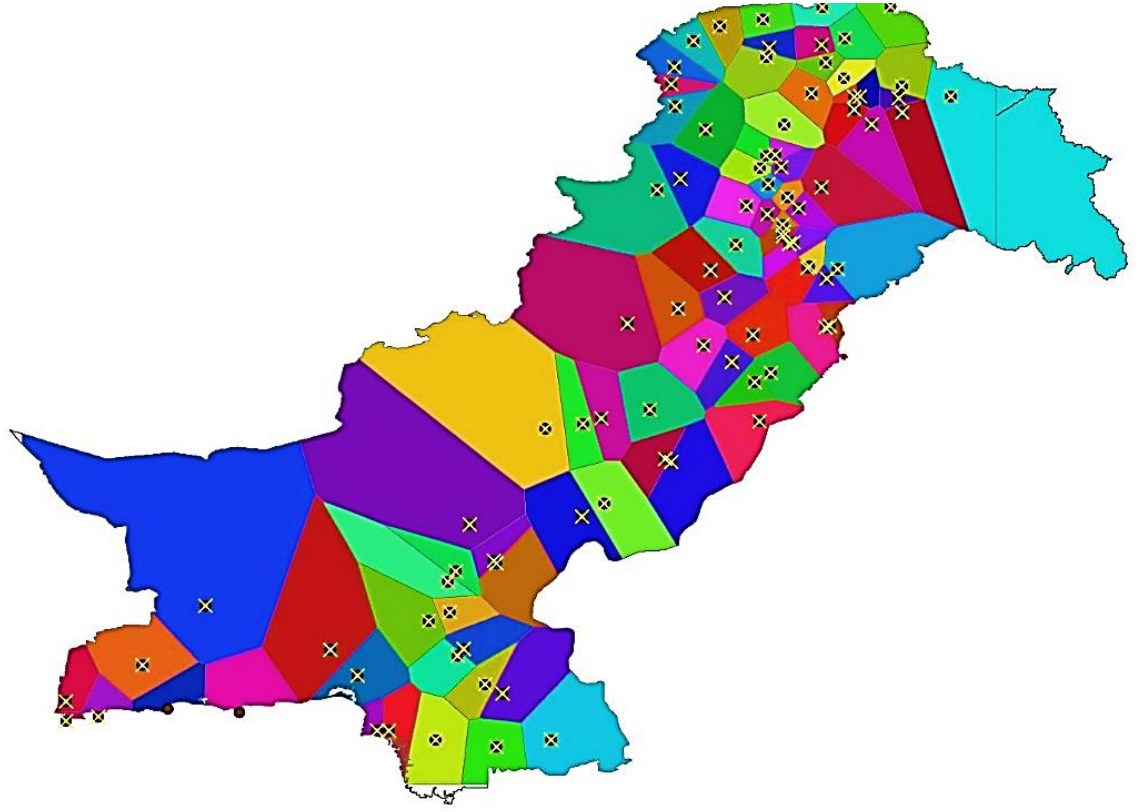
Figure 2. Thiessen polygon to calculate aerial precipitation of study area.